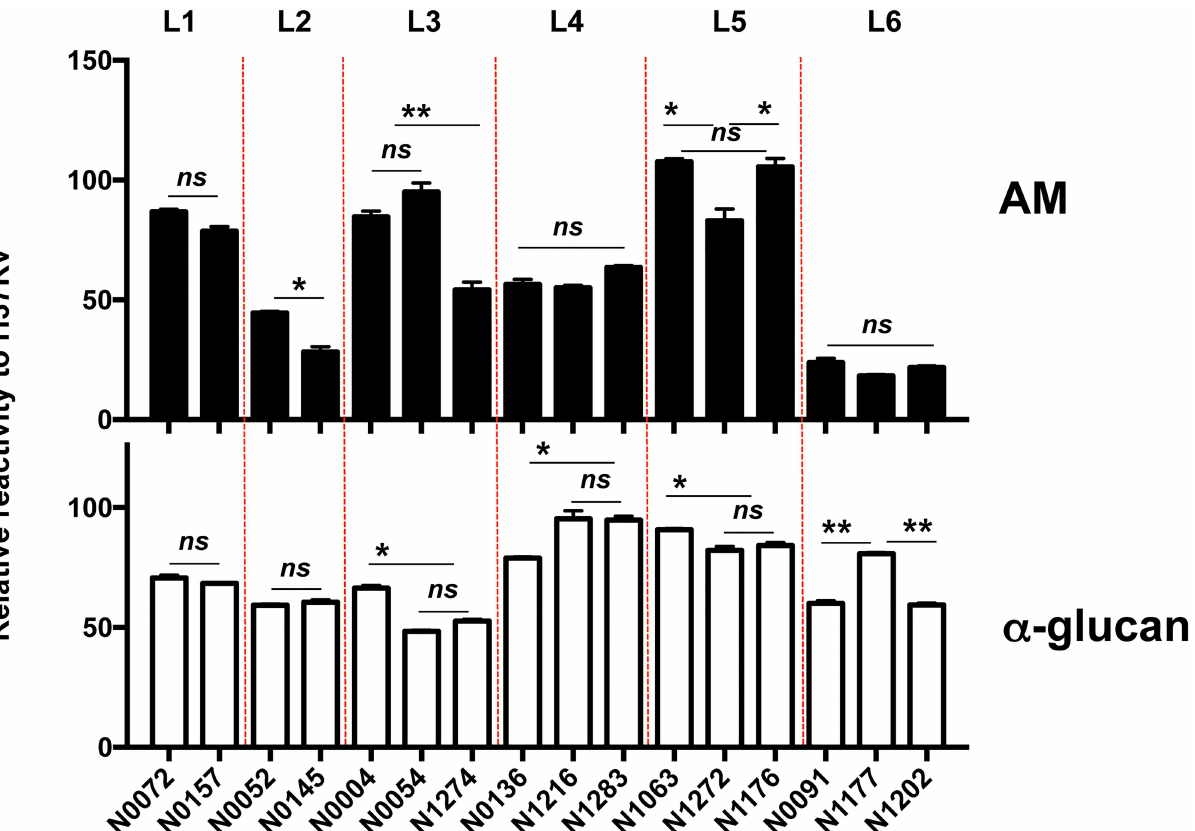
Fig 6. Antigenic variability of AM among Mtb isolates. Relativereactivity of Mtb isolates representing 6 of known lineages.The bindingis shown as the percentage of reactivity comparedto Mtb H37Rv. Data are mean +/- sem. Results are representative of two independent experiments. ( ns , non significant, * P < 0.05, ** P < 0.01,one-wayANOVA with Tukey